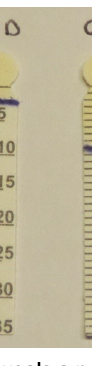
Figure 4: Shirmer I test reveals a nearly complete lack of tear secretion on the right side (1–2 mm) as compared to a normal tear secretion in the left eye (9–10